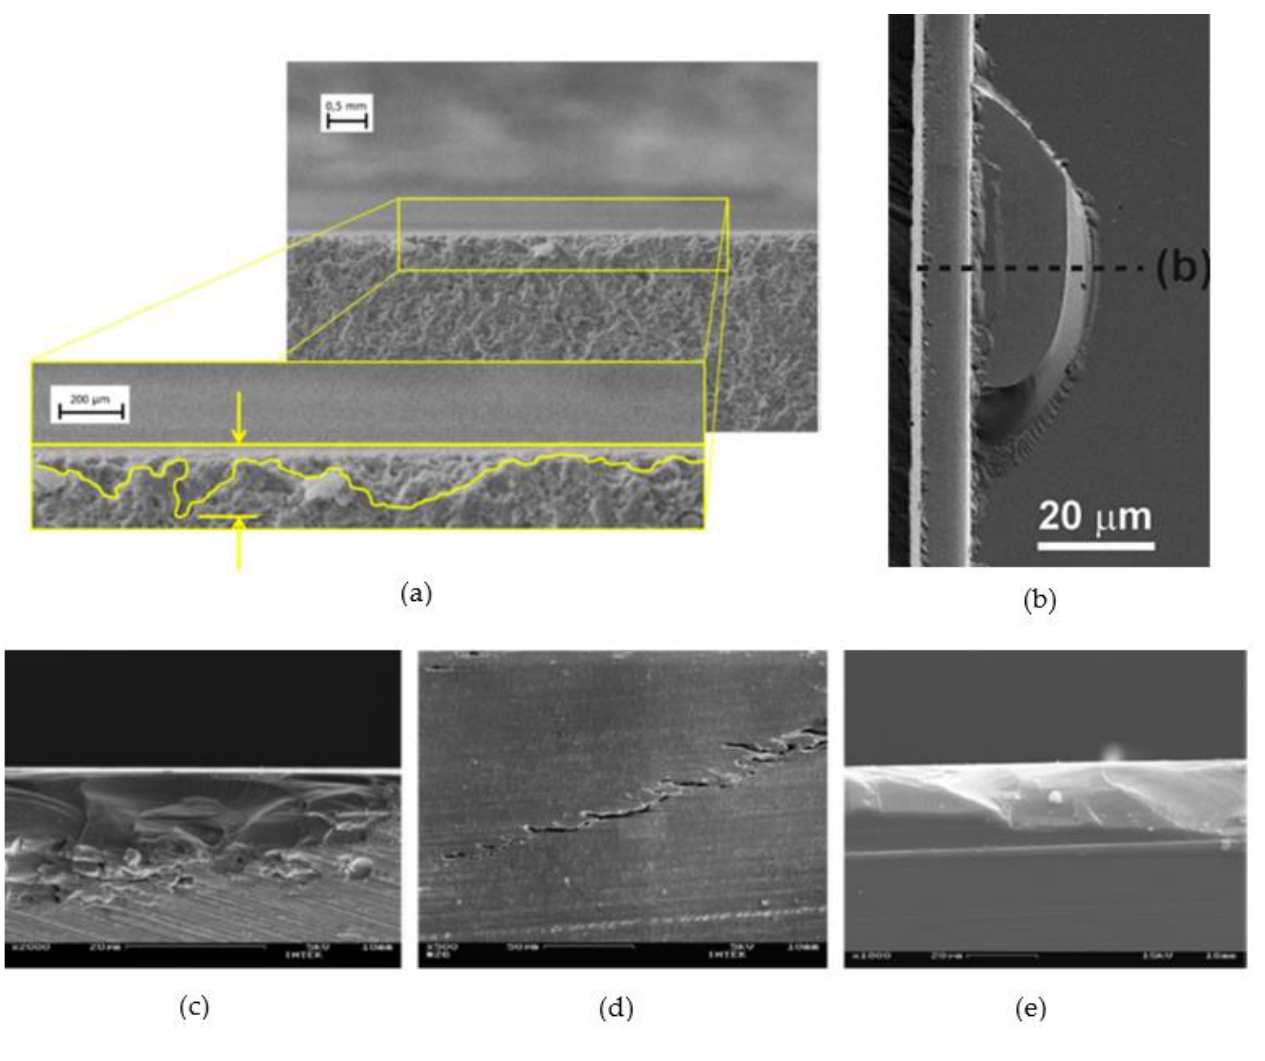
Figure 10. ( a ) Chip measuring procedure [45]; ( b ) top view of the chipping for directly bonded wafer after dicing; defects due to the blade dicing. Adapted with permission from Ref. [56]. 2020, Elsevier; ( c ) chipping at the front side edge; ( d ) cracks at the side wall; ( e ) chipping at the back side edge. Adapted with permission from Ref. [57]. 2014, Elsevier.